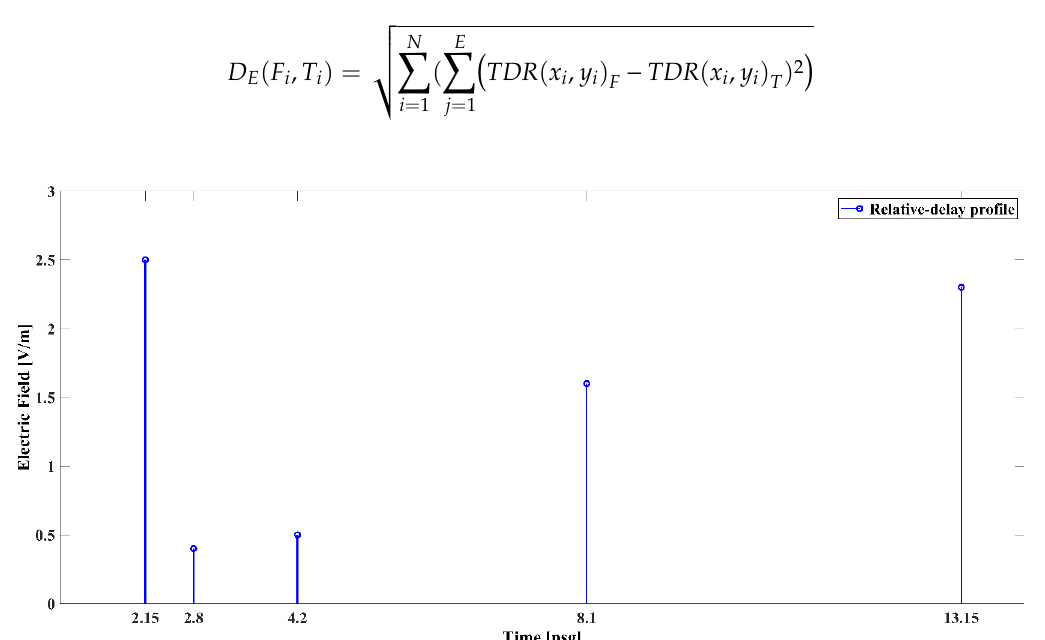
Figure 3. Relative delays and levels between rays due to ray-tracing effects.